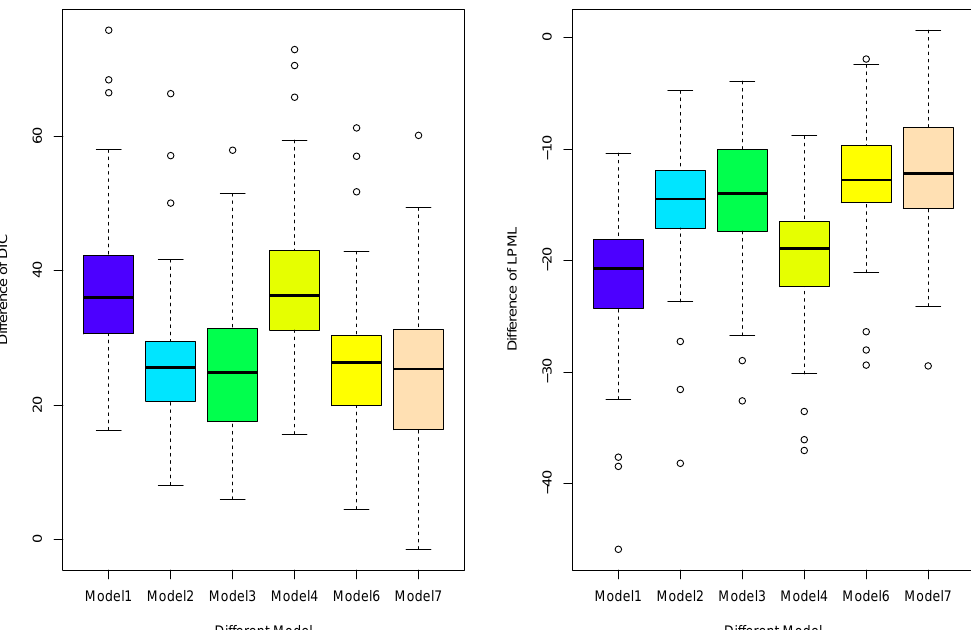
Figure 2. Deviance information criterion (DIC) and logarithm pseudo marginal likelihood (LPML) difference between candidate models and true model (model 5) of Simulation 1 (( left ) DIC, ( right ) LPML).